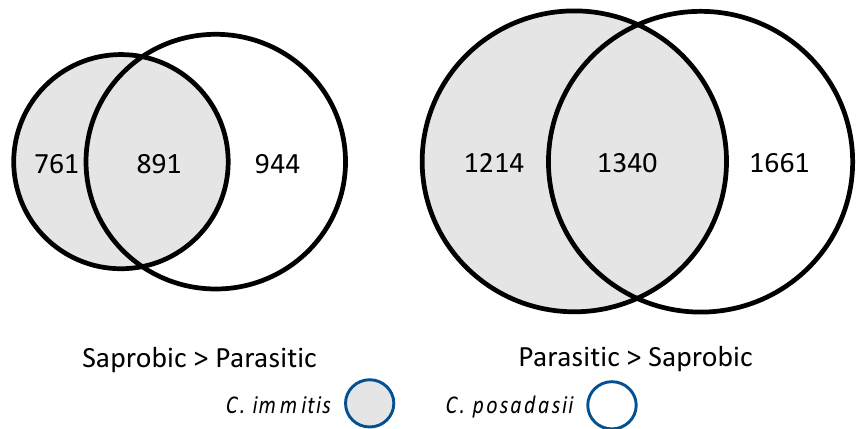
Figure 11. Comparison of differentially regulated genes in C. immitis and C. posadasii. Venn diagrams showing the number of genes commonly differentially regulated in the saprobic vs. parasitic growth phases of C. immitis and C. posadasii . The figure is from [15].